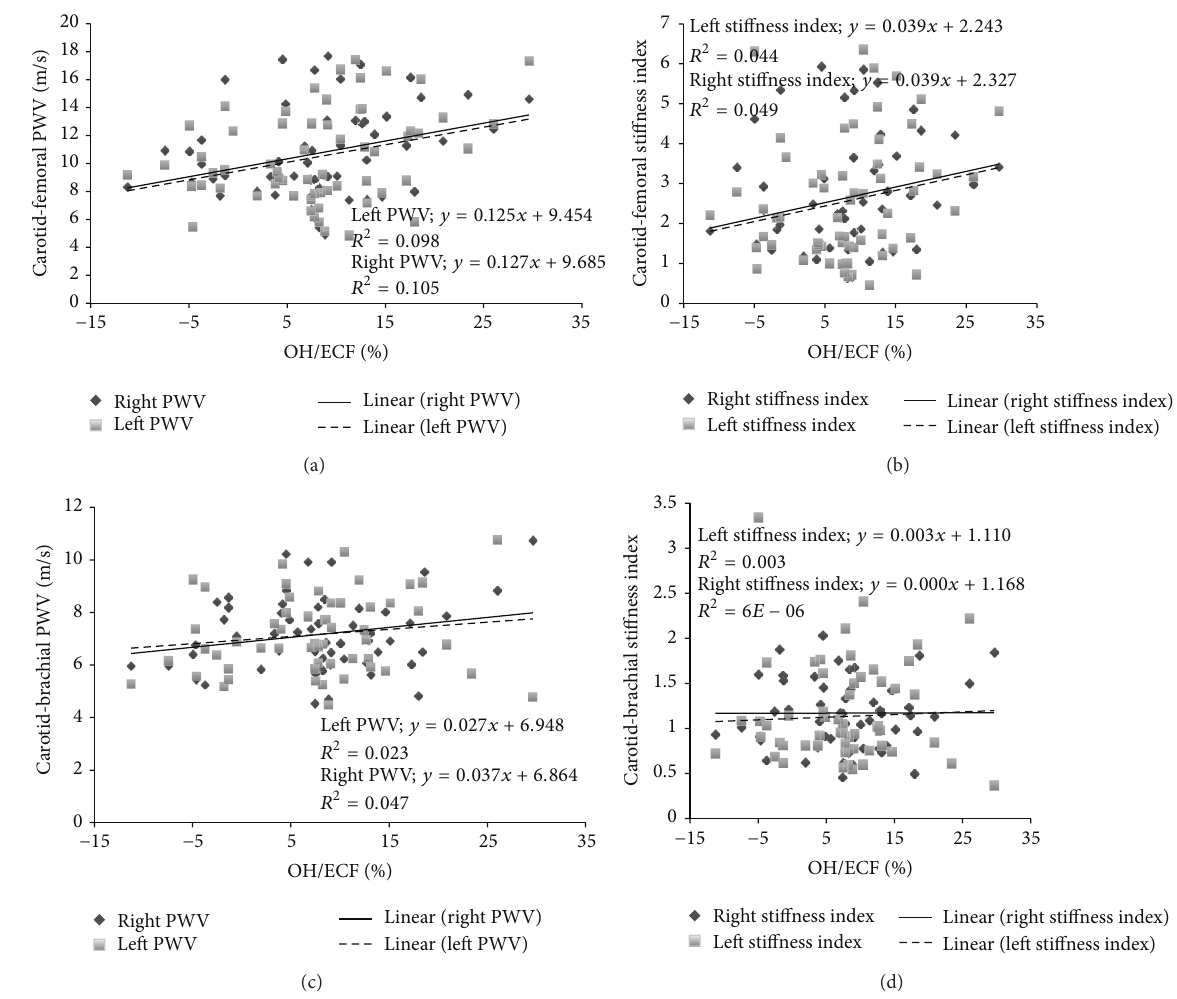
Figure 4: Pulse wave velocity (PWV) and hydration status evaluated through overhydration/Extracellular fluid ratio (OH/ECF) measured in relative values using multi-impedancimetric technique. The carotid-femoral PWV-OH/ECF relationship shows a significant relationship ( 𝑃 < 0.05 ), as does the stiffness index ( 𝛽 )-OH/ECF relationship ( 𝑃 < 0.005 ).